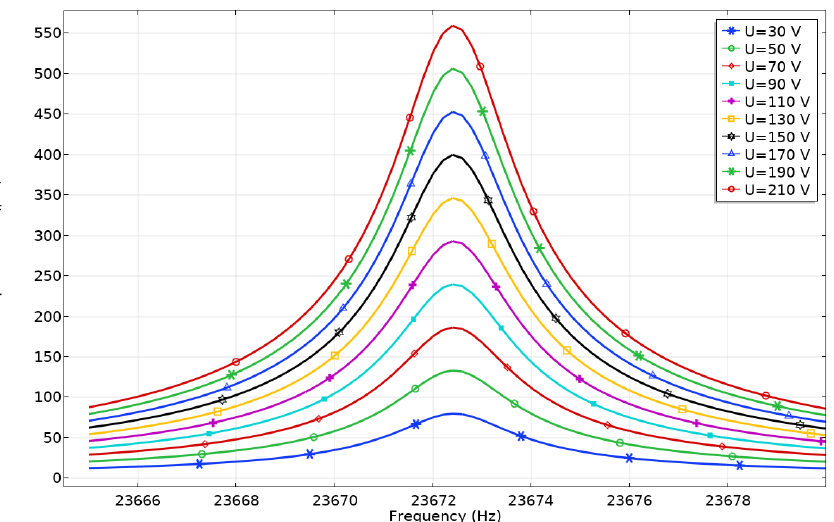
Figure 10. Displacement—frequency characteristics of the platform while different excitation voltages are applied to Plate 1.